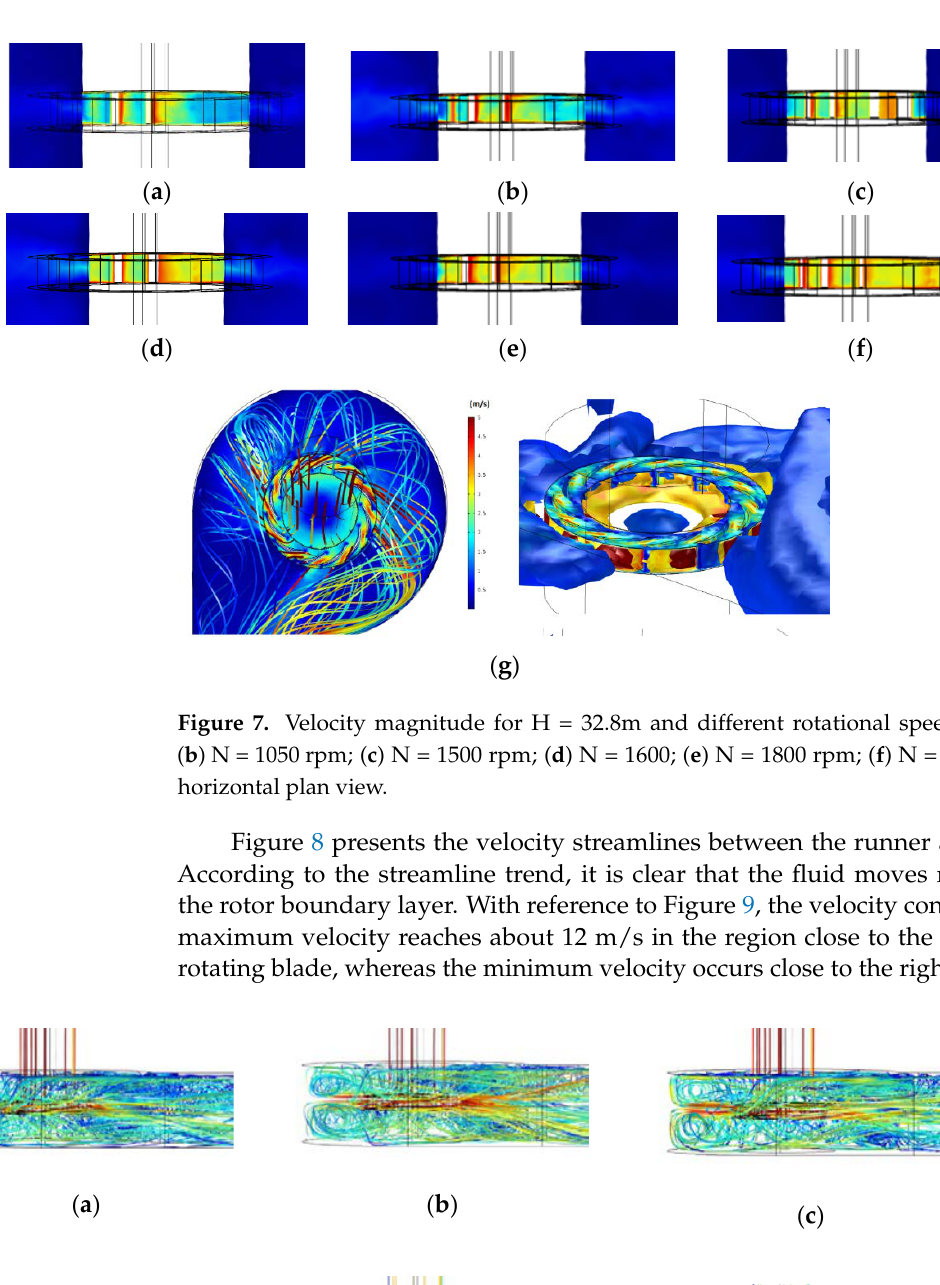
= 750 rpm; = 1850 rpm. N N